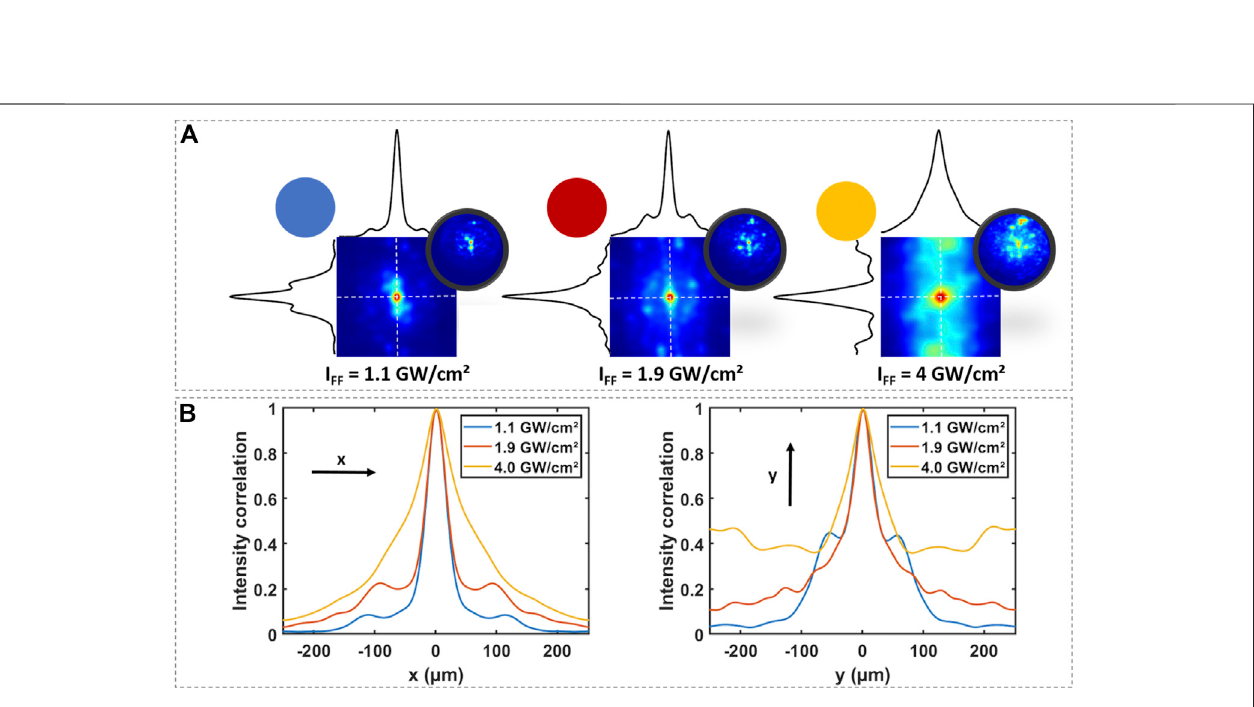
Frontiers in Physics |